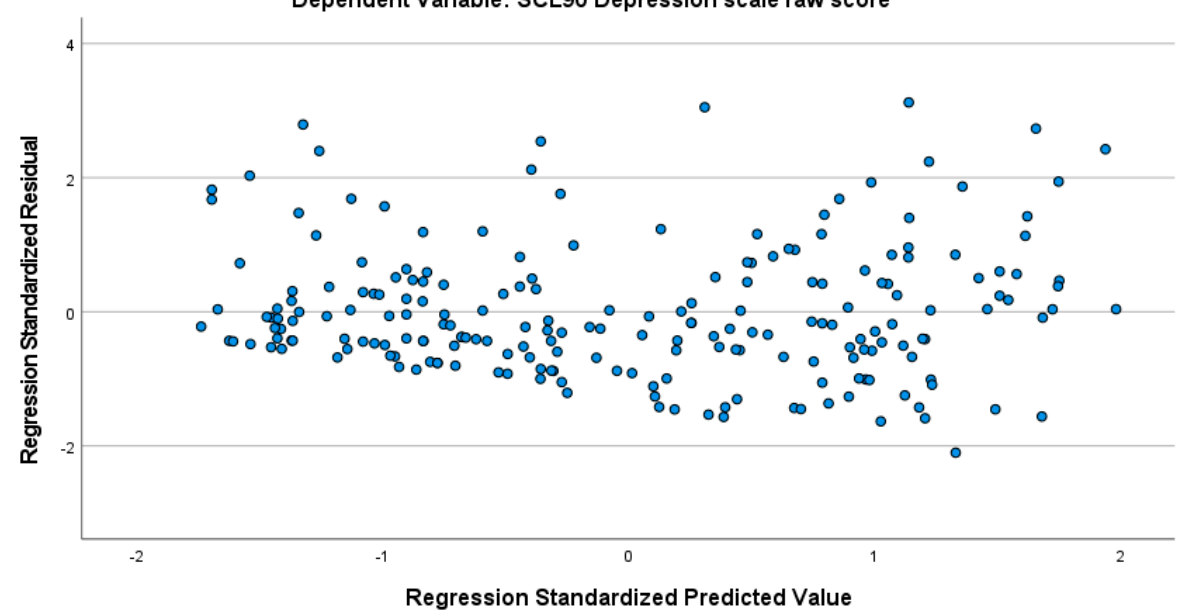
Figure A3. Scatterplot showing standardized residuals for SCL-90 Depression scale.